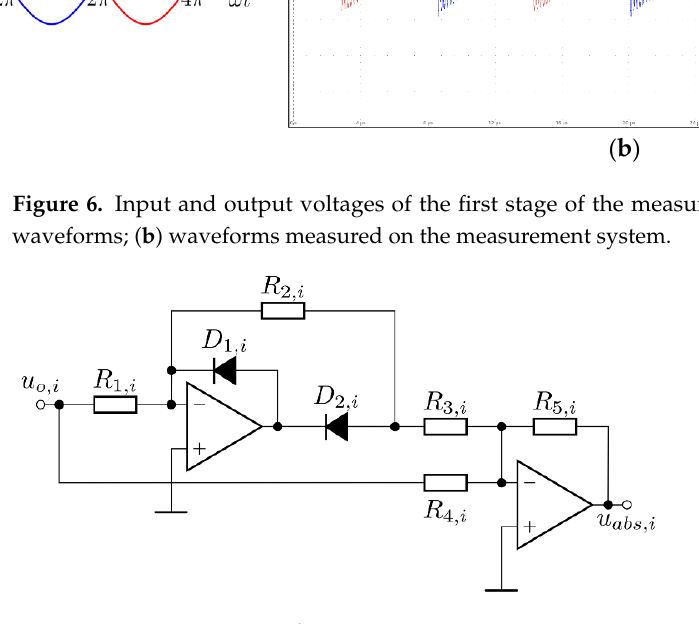
Figure 6. Input and output voltages of the first stage of the measurement circuit: ( a ) theoretical waveforms; ( b ) waveforms measured on the measurement system.